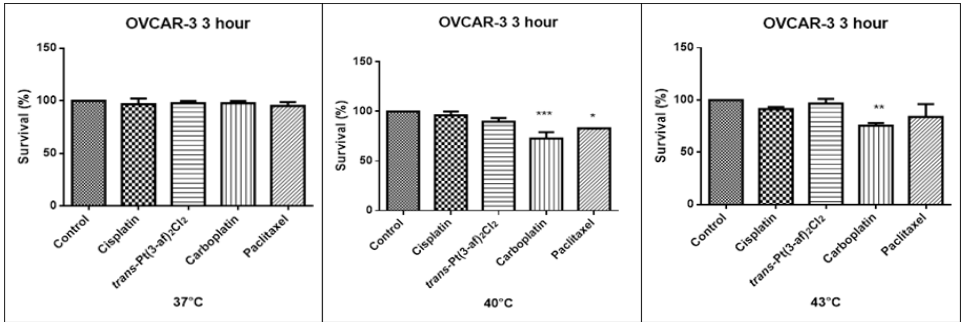
Figure 6. The effect of elevated temperatures on OVCAR-3 ovarian cancer line cells was determined by MTT test. Data on the figures are presented as mean values obtained from three independent experiments * ( p < 0.05), ** ( p < 0.01), *** ( p < 0.001).